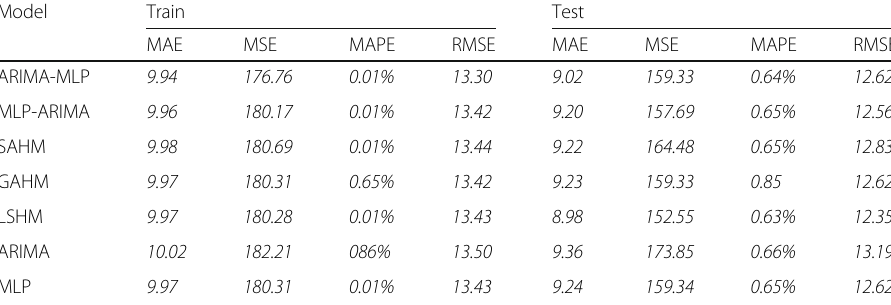
Table 3 Performance of models for S&P 500 using train and test datasets Model Train Test MAE